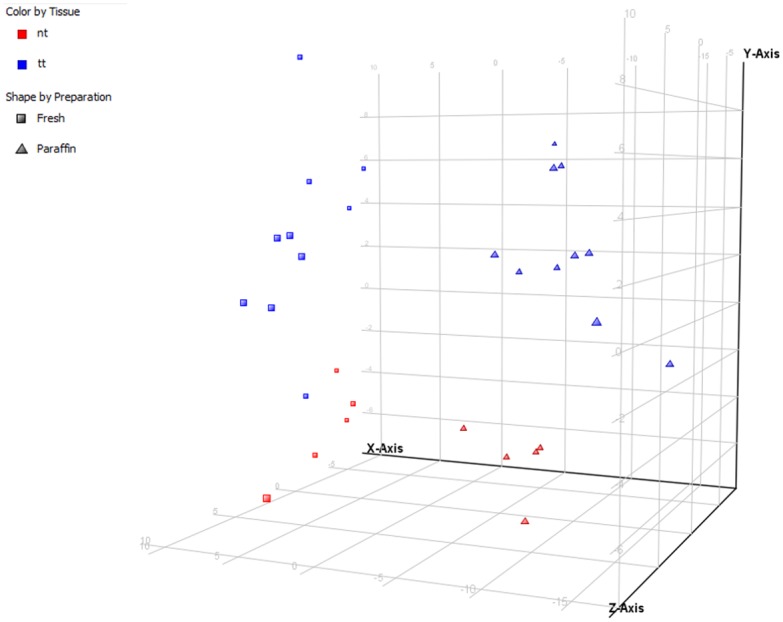
Principal component analysis plot.Visualization of the miRNA expression in fresh frozen (squares) and formalin-fixed paraffin-embedded (triangles) samples, as well as miRNA expression separation of tumor (blue) and non-malignant samples (red).